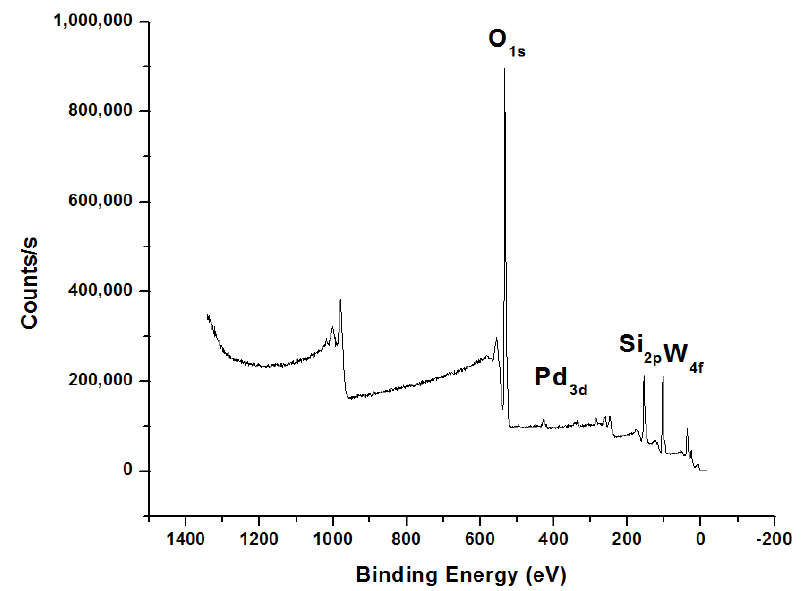
Figure 4. XPS spectra of the 1%Pd-HPW/SiO 2 bi-functional